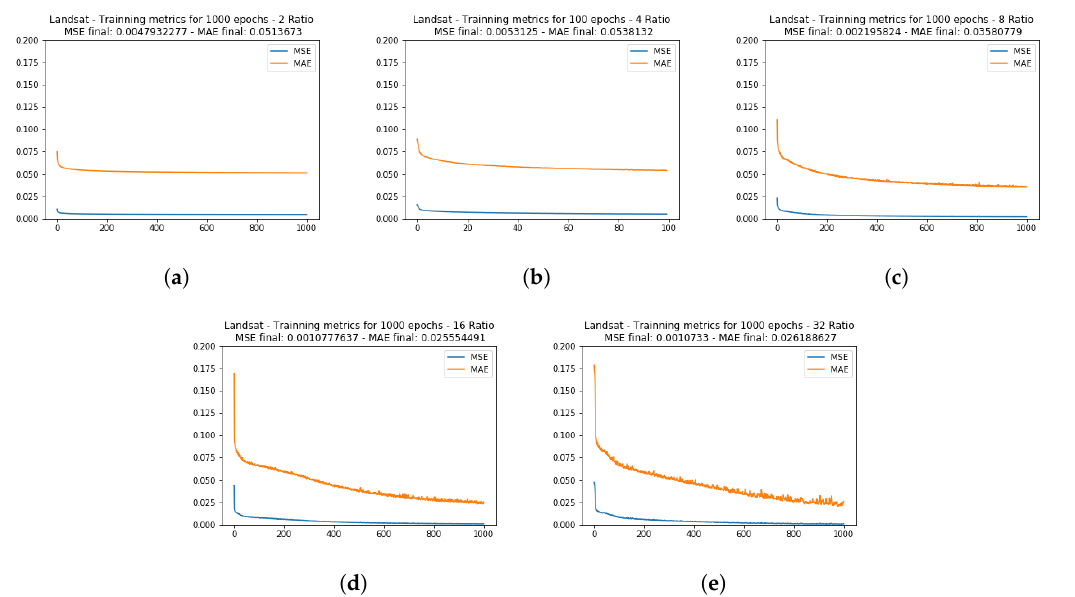
Figure 9. Mean squared error (MSE) and mean absolute error (MAE) training metrics for the Landsat dataset test image, for the ratios of 2 ( a ), 4 ( b ), 8 ( c ), 16 ( d ), and 32 ( e ).